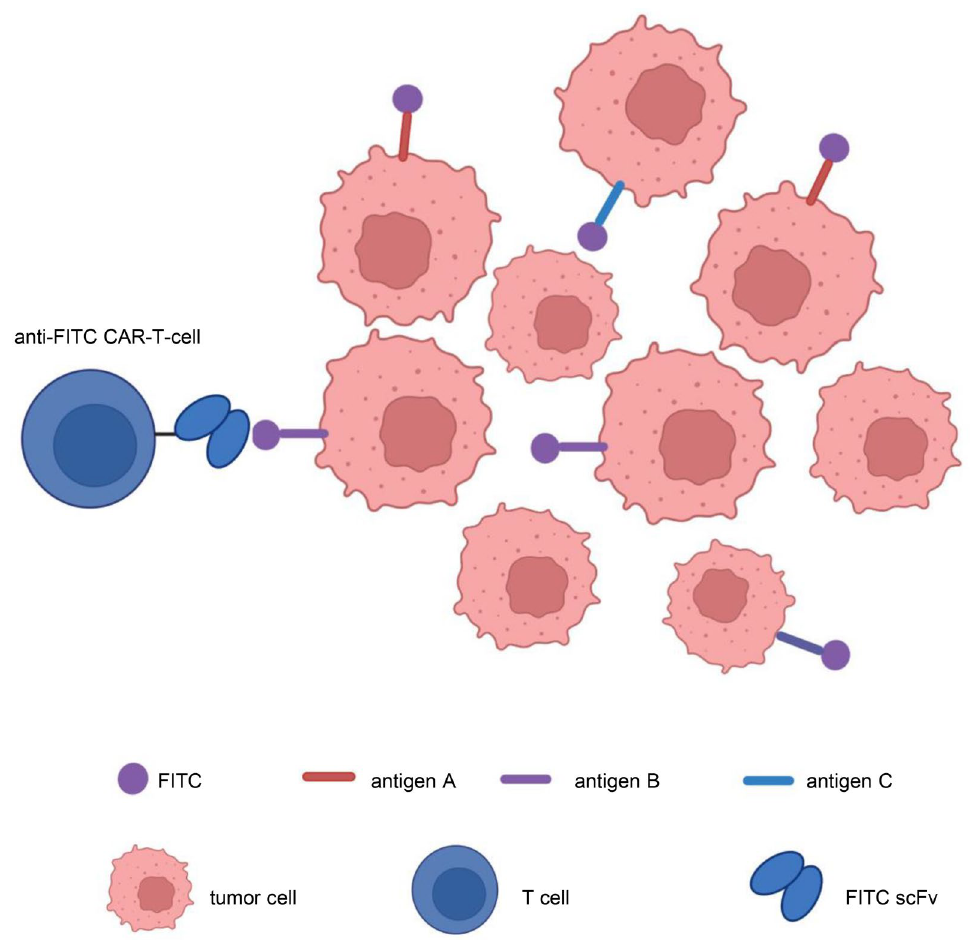
Figure 6. Aptamer CAR-T-cell technology. Construction of universal CAR-T cells expressing nontumor-associated antigens, such as fluorescein isothiocyanate (FITC)-CAR-T cells, targeting multiple target antigens on the surface of tumor cells through a mixture of bispecific aptamers. Illustration was created with Biorender.com.